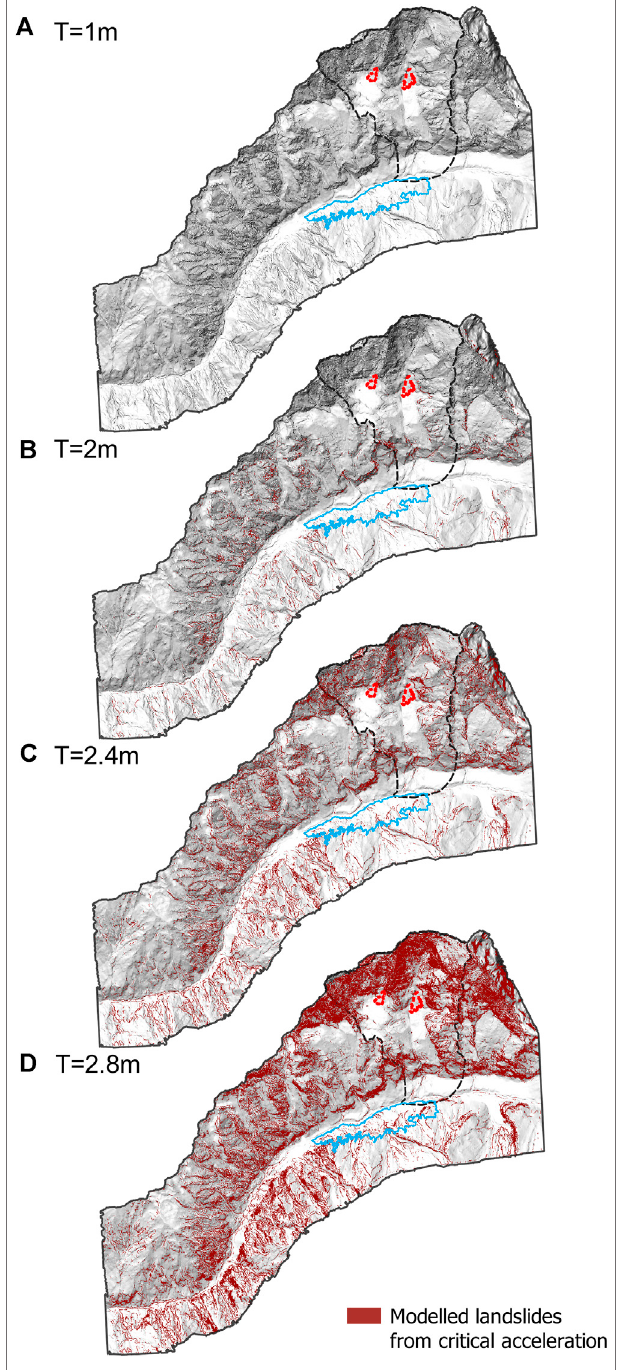
FIGURE 7 | Predicted earthquake-triggered landslide maps for different assumed landslide thicknesses (A – D) with a DEM cell size of 4 m.